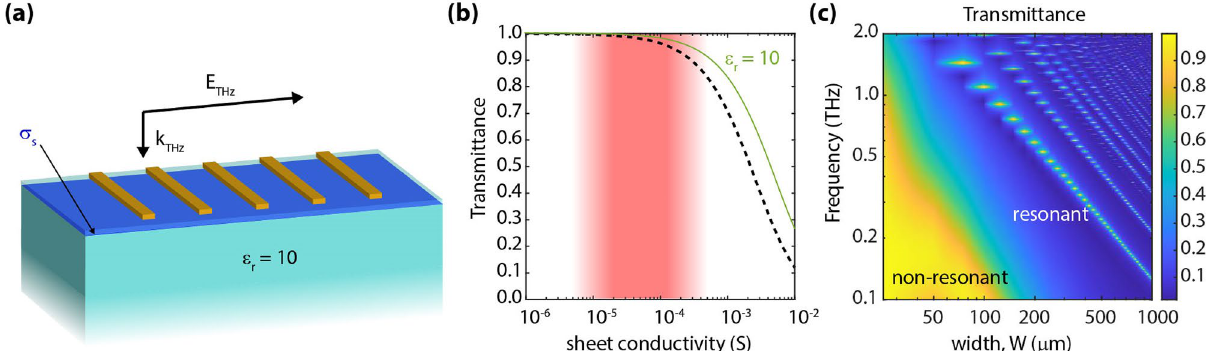
Figure 5. Effect of an optically thick substrate on the layer and grating response. ( a ) Illustration of the analyzed geometry. (image created in Adobe Illustrator v25.0.1, https ://www.adobe .com/produ cts/illus trato r.html). ( b ) Transmittance versus sheet conductivity for a dispersion-free conductive layer suspended in free-space (dashed black curve) and on top of a semi-infinite substrate with relative permittivity ε r = 10 (continuous green curve). Presence of a substrate shifts the characteristic curve towards higher conductivity levels. ( c ) Colormap of transmittance versus frequency and stripe width, W; S was fixed to S = 2 µm in the absence of a conductive layer, i.e., σ s = 0. Presence of a substrate redshifts the resonances with respect to the situation simulated in Fig.